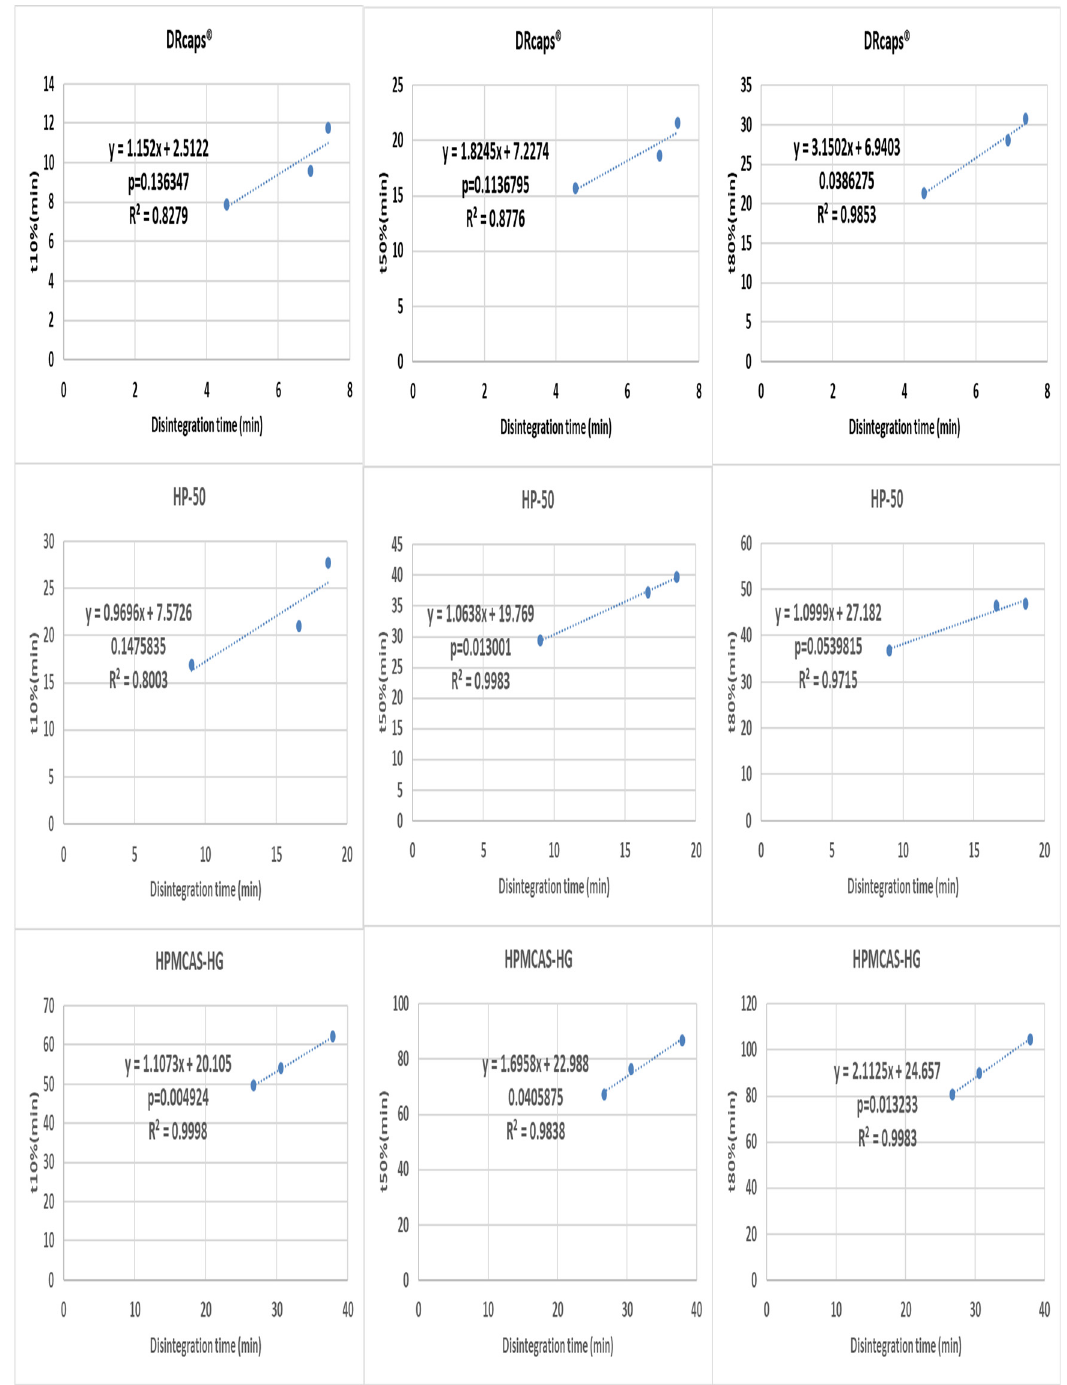
Figure 8. Correlation of disintegration times with different dissolution (paddle apparatus) parameters for one formulation in different media. The p -value is a one-sided value for a t -test applied to the slope.